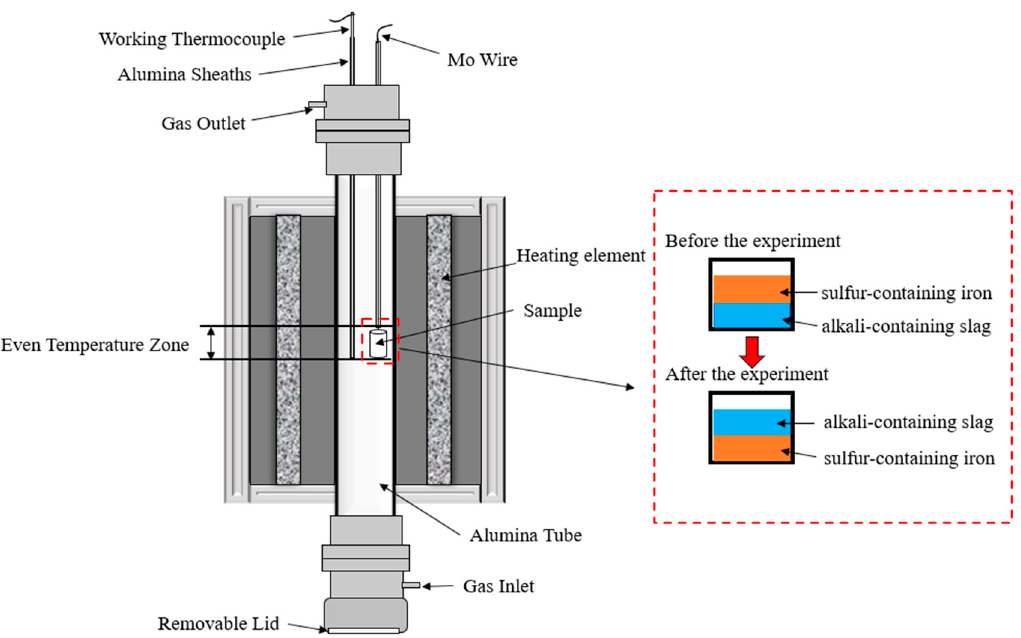
Figure 1. The schematic diagram of the experimental method desulfurization and removal of alkali. Table 1. Experimental conditions for slag-metal reaction